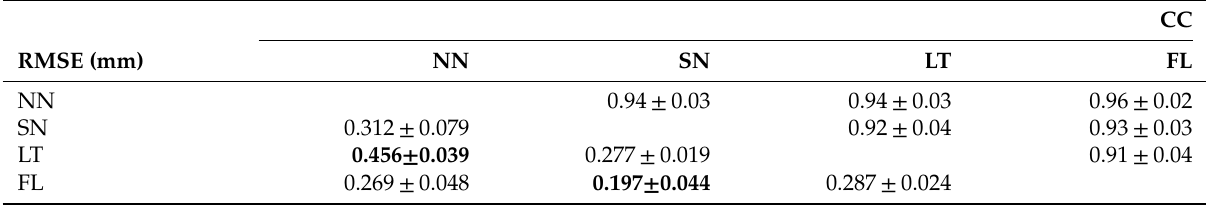
Table 1: Correlation coefficient (CC, values in upper right half of the table) and root mean squared error (RMSE, values in lower left half of the table) between the methods.